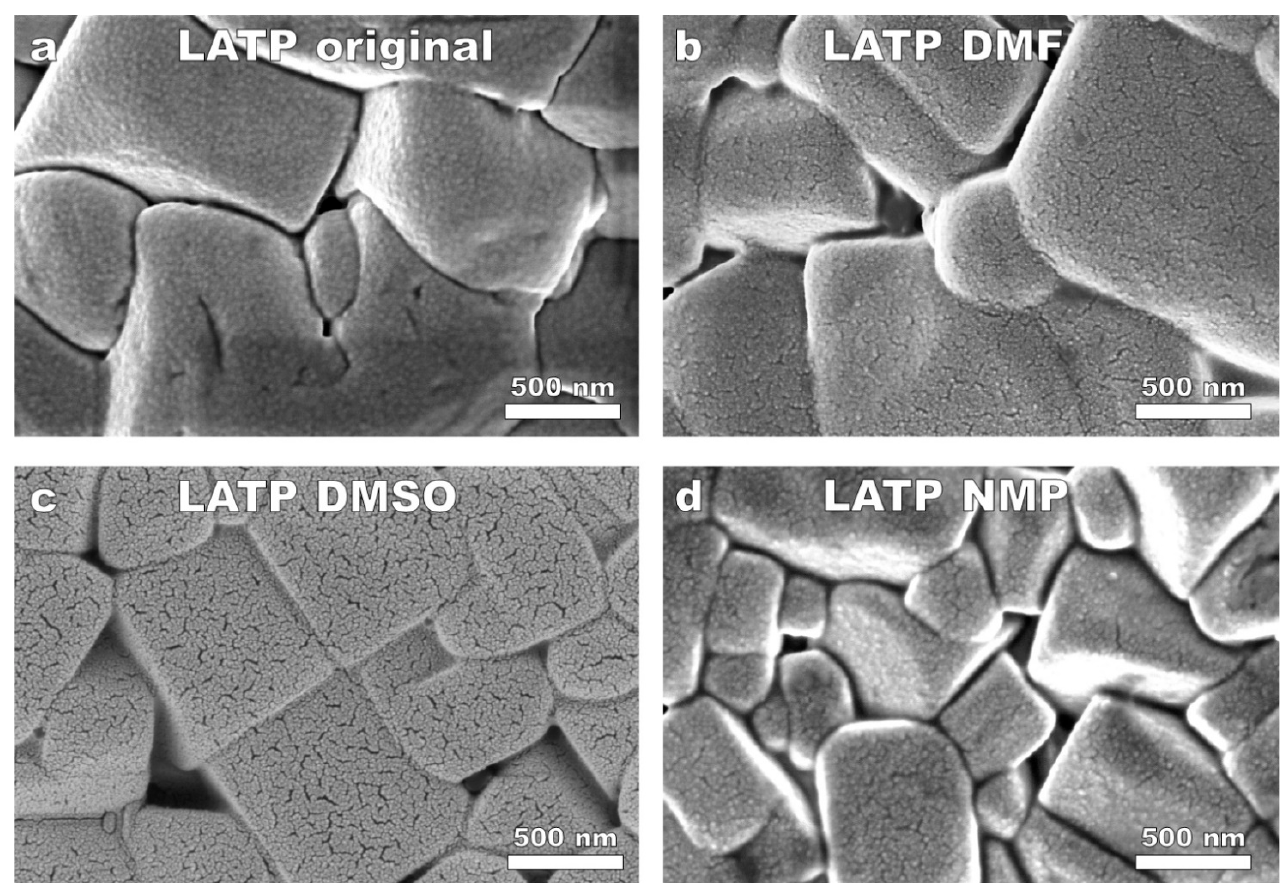
Figure 3. SEM images of ( a ) pristine LATP ceramic and that after soaking in ( b ) DMF, ( c ) DMSO, and ( d ) NMP.